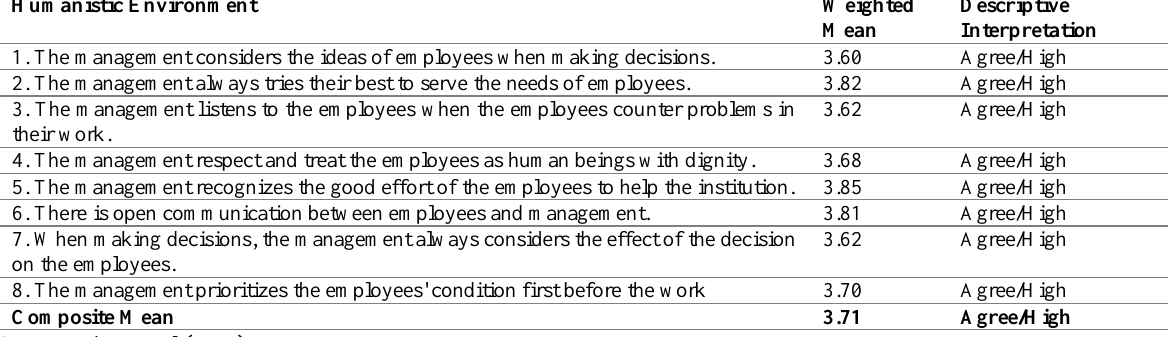
Table 5: Humanistic